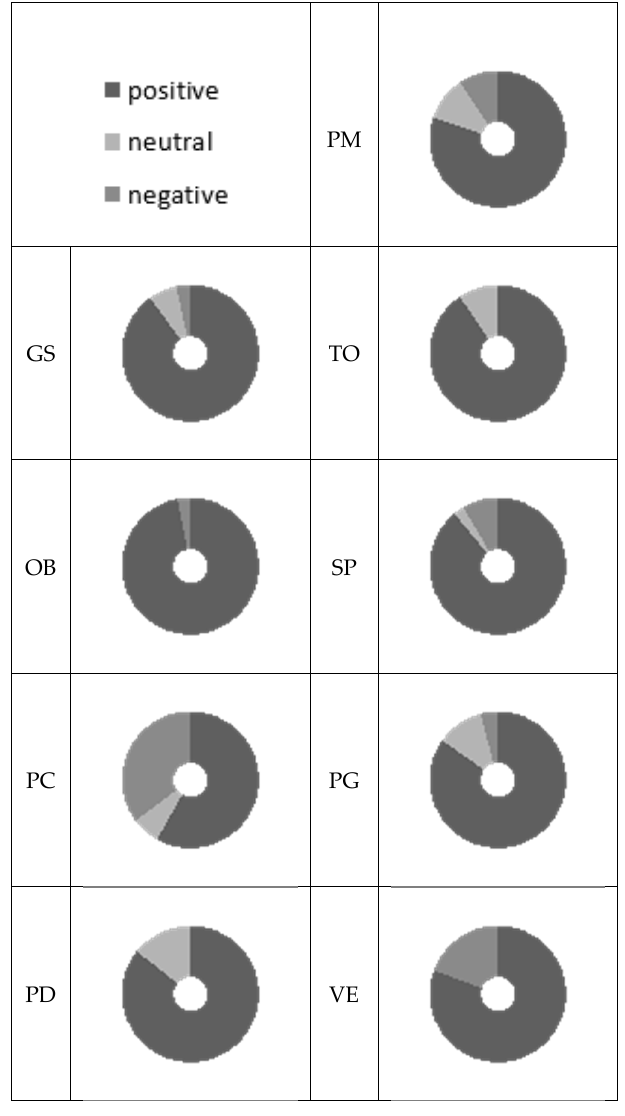
Figure 4. Preferences in terms of noise (external ring) and visual (internal ring) elements for each area.